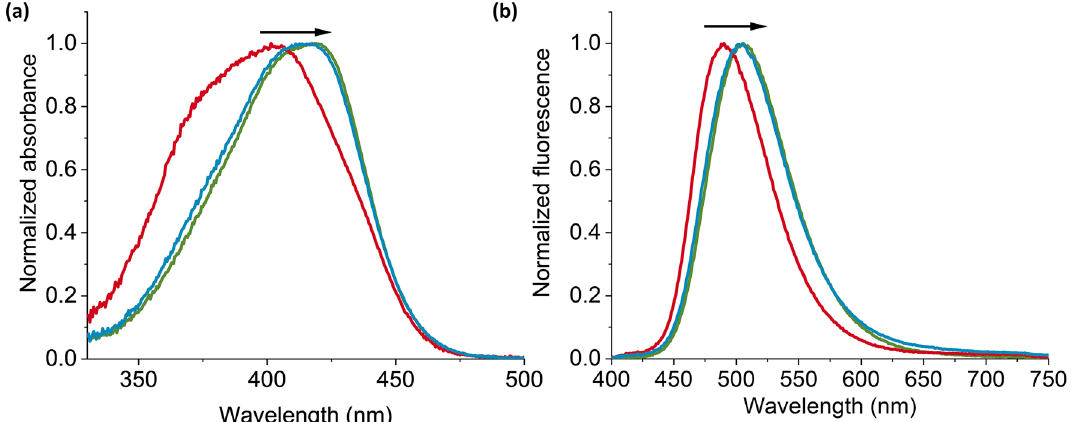
Figure 3. Normalized ( a ) absorption and ( b ) fluorescence spectra of the prepolymerization solutions in chloroform showing spectra of I + MAAm + EGDMA (red line), I + MAAm + EGDMA + GPS-TBA (blue line) and I + MAAm + EGDMA + MPA-TBA (green line). λ ex = 385 nm.